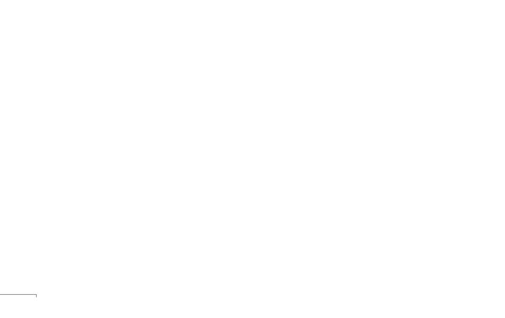
Figure 2. Quantification of viability for hiPSC-derived neural progenitors treated with genipin (biological n = 24, technical n = 5, data reported is mean ± standard error of the mean) * indicates p < 0.5 compared to the